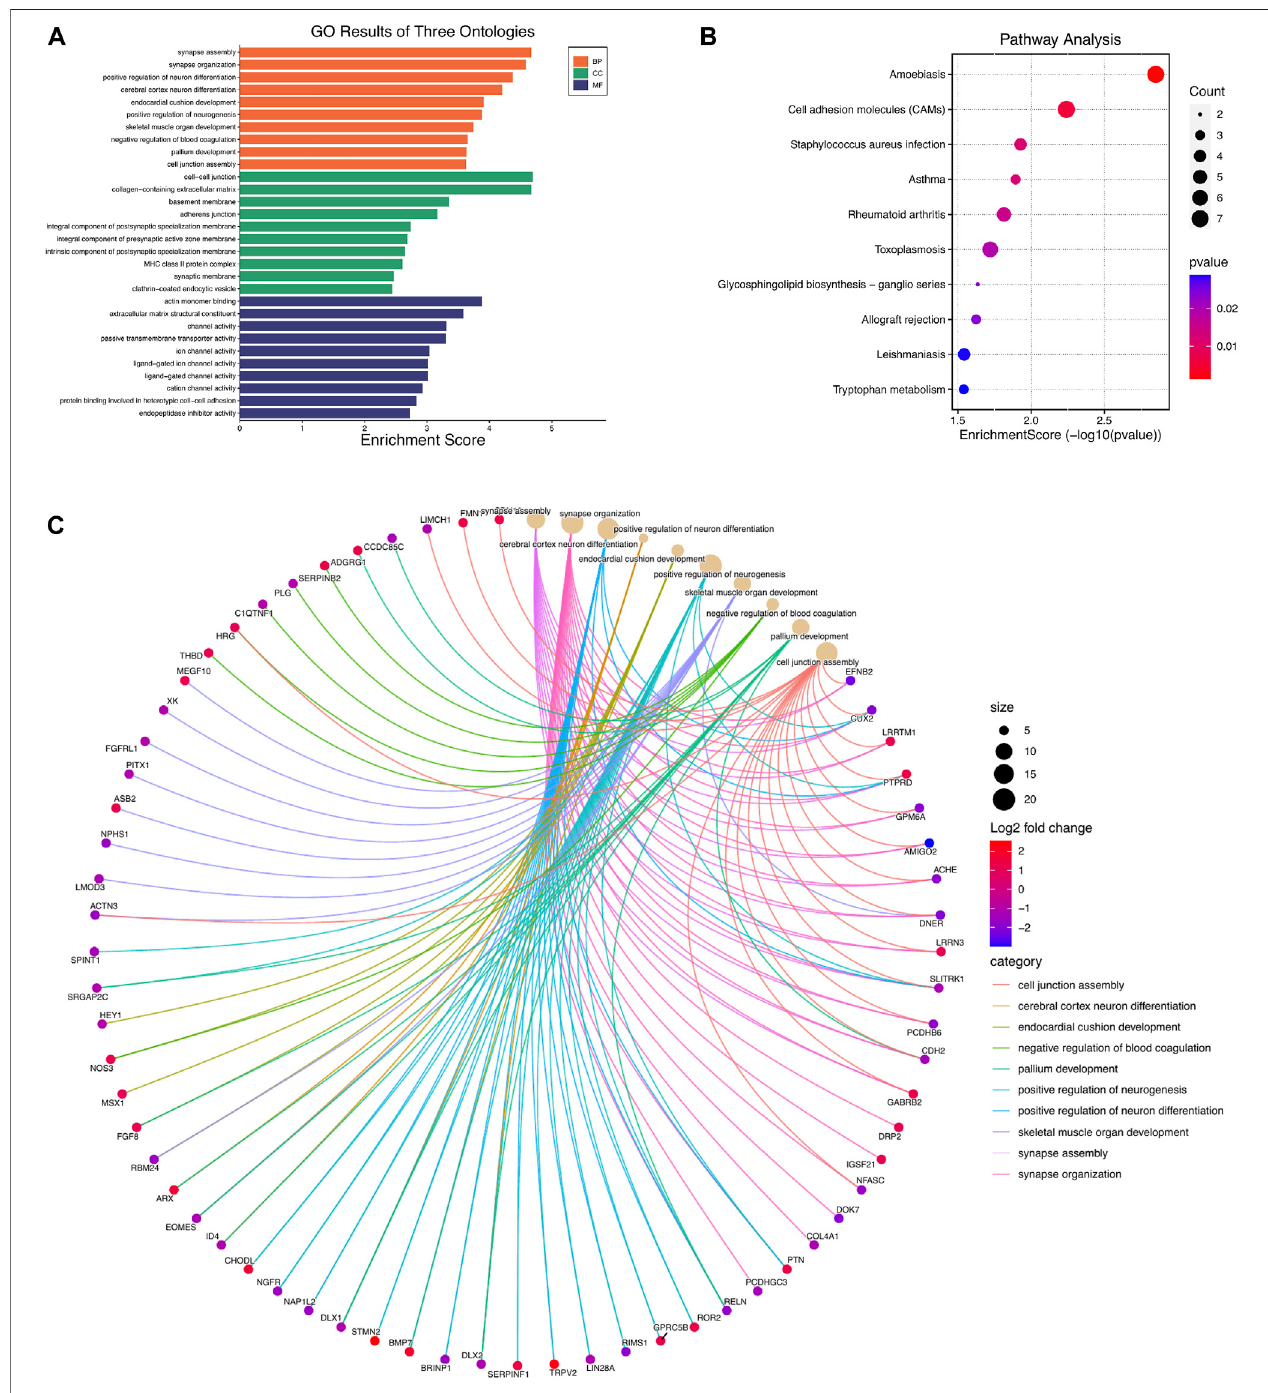
FIGURE 2 | GO and KEGG pathway enrichment analyses of differentially expressed mRNAs (DEGs). (A) Top 10 enriched GO terms of the DEGs. (B) cnetplot showing the top 10 enriched biological processes of DEGs (C) . The bubble plot showing top 10 enriched KEGG pathways of DEGs.